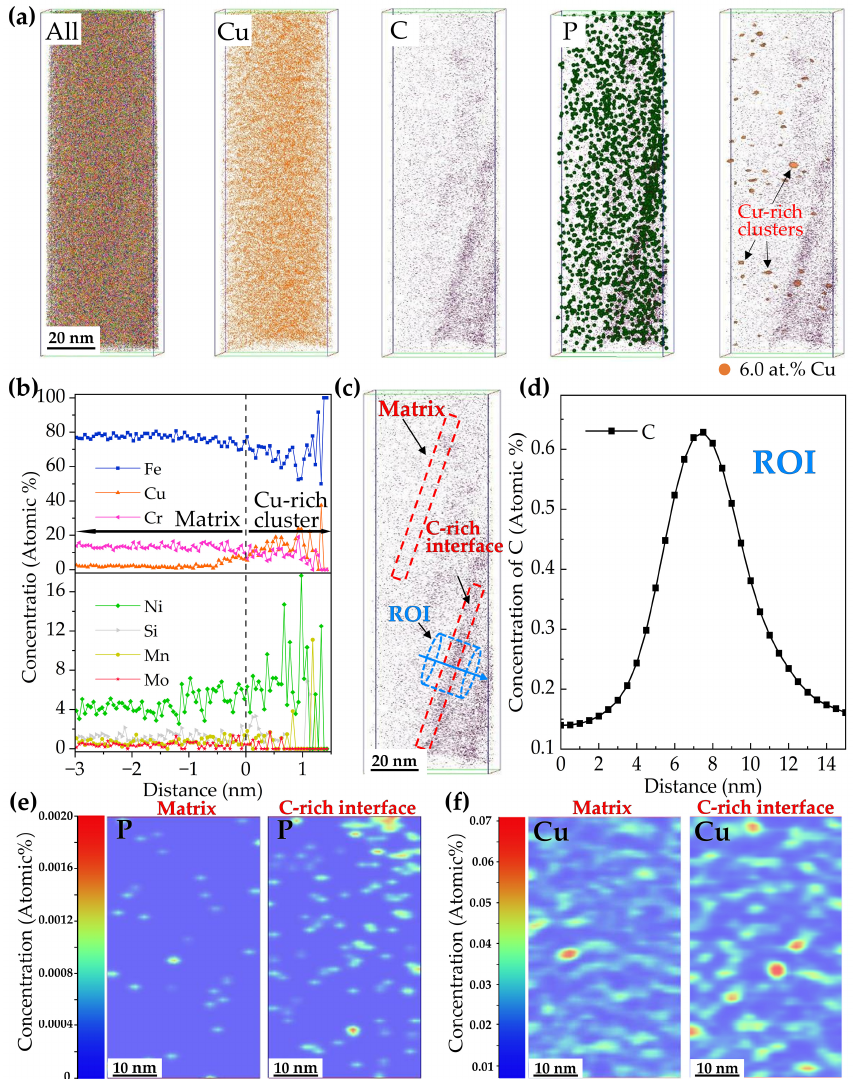
Figure 7. ( a ) The three dimensional (3 ‐ D) atomic probe maps and 3 ‐ D reconstructions based on isoconcentration surfaces of 6.0 at.% Cu in the 3Cu ‐ steel tempered at 450 °C. ( b ) Proximity histograms of the Cu ‐ rich clusters displayed in ( a ). ( c ) The 3 ‐ D atomic probe map of the C atoms and the region of interest (ROI), ( d ) a 1 ‐ D concentration profile of the ROI displayed by the light blue cylinder in ( c ). The 2 ‐ D concentration mappings of P ( e ) and Cu ( f ) taken from the “matrix” and “C ‐ rich interface” regions are displayed by the red rectangles in ( c ).